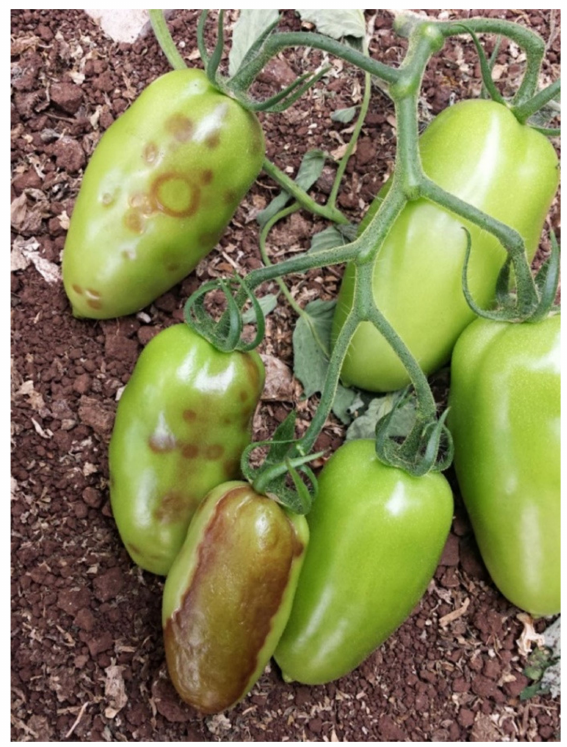
Figure 10. Necrotic and brownish ring spots on immature fruits caused by Tomato spotted wilt